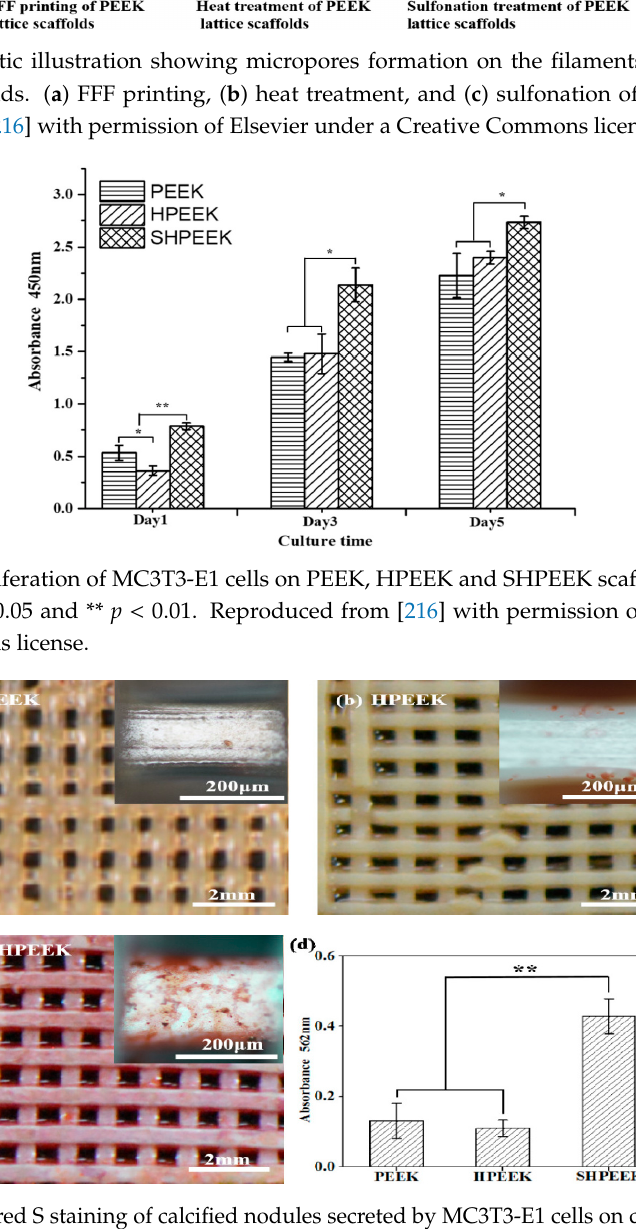
Figure 30. Alizarin red S staining of calcified nodules secreted by MC3T3-E1 cells on different scaffolds at day 7. Optical photographs of Alizarin red S staining of MC3T3-E1 cells on ( a ) PEEK, ( b ) HPEEK, and ( c ) SHPEEK scaffolds. ( d ) Quantitative analysis of deposited calcified nodules. (** p < 0.01). Reproduced from [216] with permission of Elsevier under a Creative Commons license.